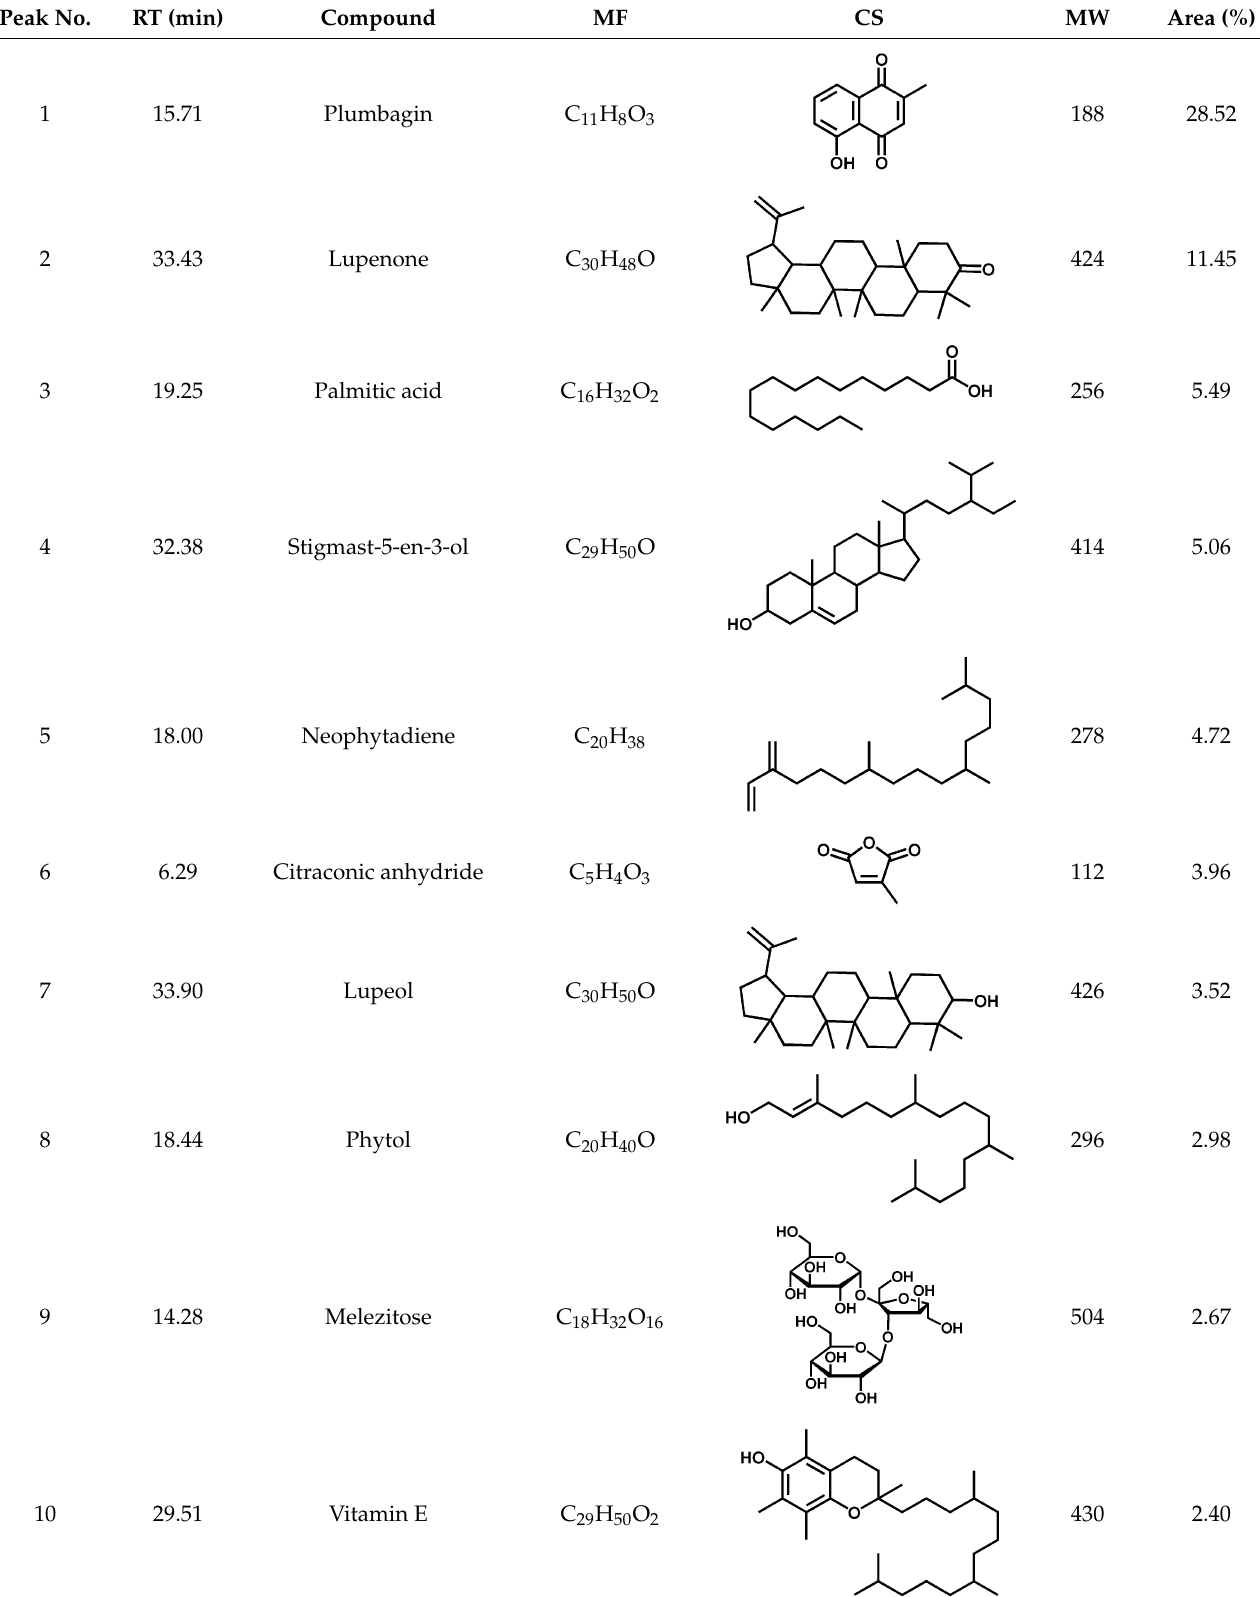
Table 3. GC-MS analysis of N. miranda